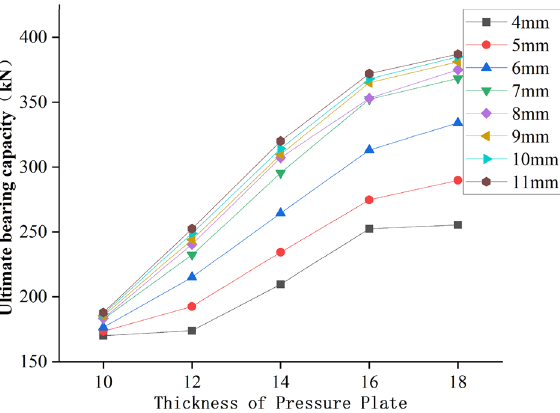
Figure 20. Relationship between ultimate bearing capacity and thickness of pressure plate of the ball table.